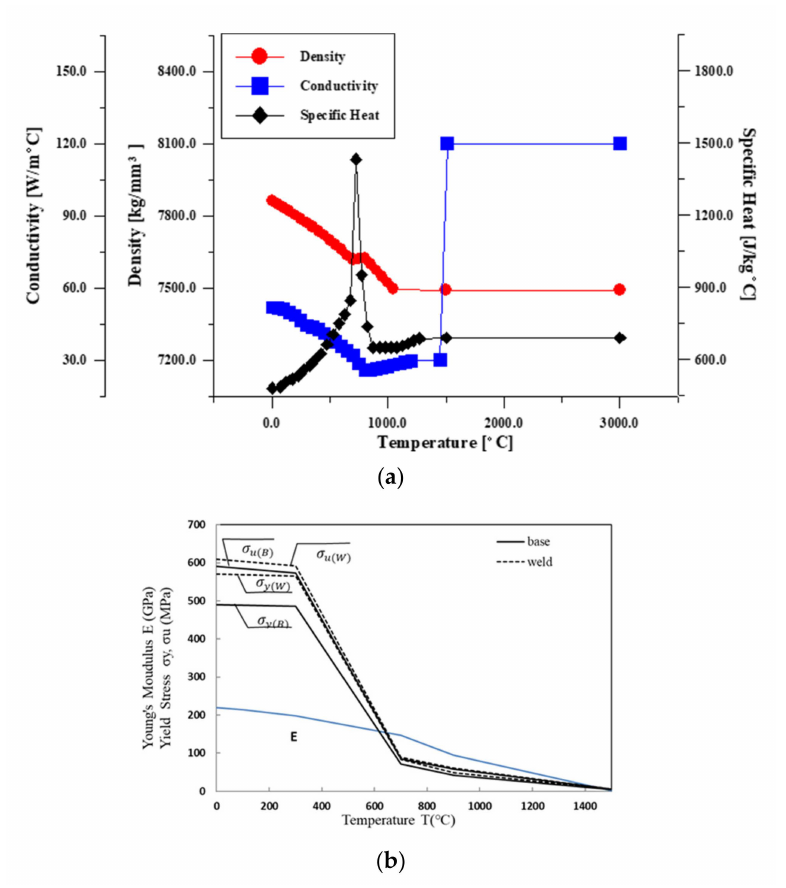
Figure 3. Material properties according to temperature: ( a ) physical properties and ( b ) mechani- cal properties.